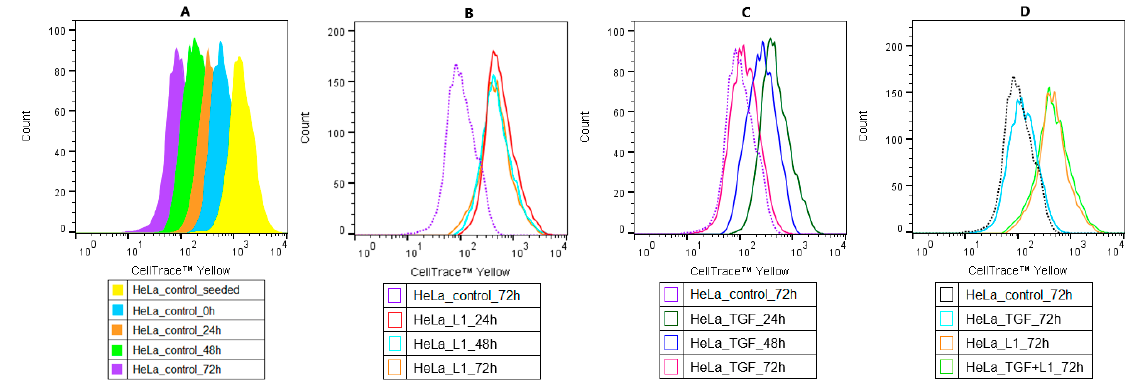
Figure 4. Flow cytometry analysis of HeLa cell proliferation stained with CellTrace™ Yellow. Control groups proliferation histograms represented by the figure ( A ), cells treated with L1 (10 µ M) ( B ), cells treated with TGF- β (10 ng/mL) ( C ), cells treated with L1 or in combination L1/ TGF- β on 72 h ( D ). Representative histograms of three independent experiments are presented.